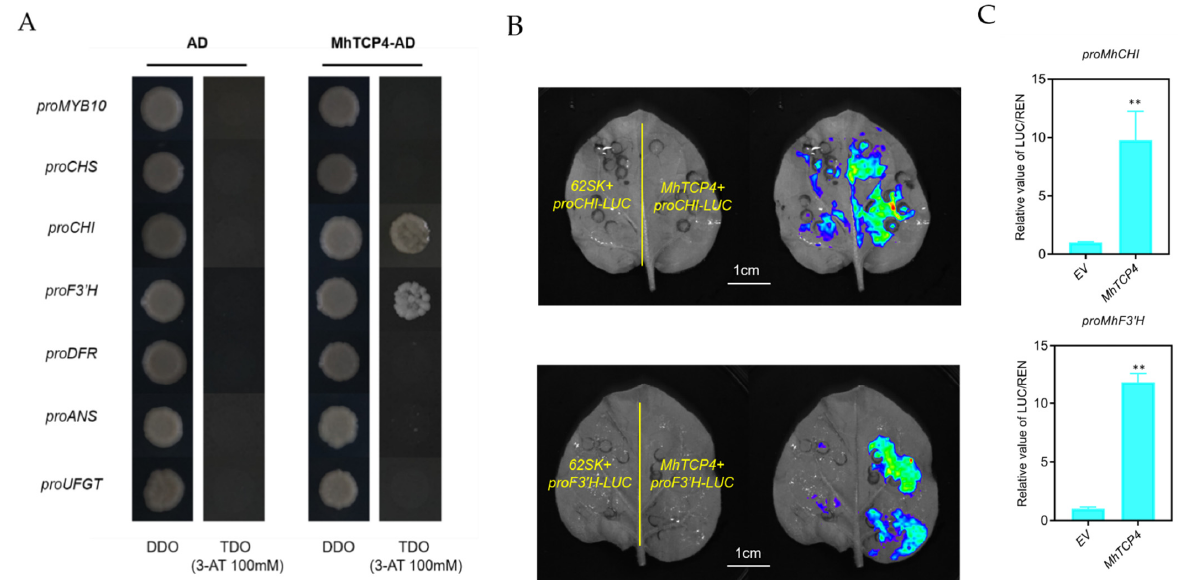
Figure 8. Effect of MhTCP4 on the promoters of anthocyanins-related genes. ( A ) Y1H analysis of the binding of MhTCP4 and the promoters related to anthocyanins biosynthesis. DDO, double-dropout medium (SD/-Leu/-Trp); TDO, triple-dropout medium (SD/-His/-Leu/-Trp). ( B ) Luciferase complementation imaging assays showing that MhTCP4 activates the promotors of MhCHI and MhF3 ′ H . ( C ) The luminescence intensity of promoters of MhCHI and MhF3 ′ H increased by MhTCP4. Values are means ± SE of three biological replicates. ** p < 0.01 using the t -test.